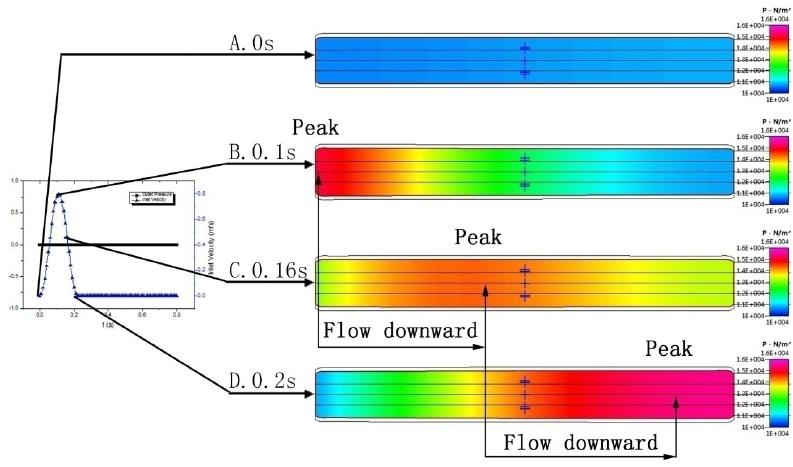
Figure 7. Pressure nephograms (A. t = 0 s; B. t = 0.1 s; C. t = 0.16 s; D. t = 0.2 s).